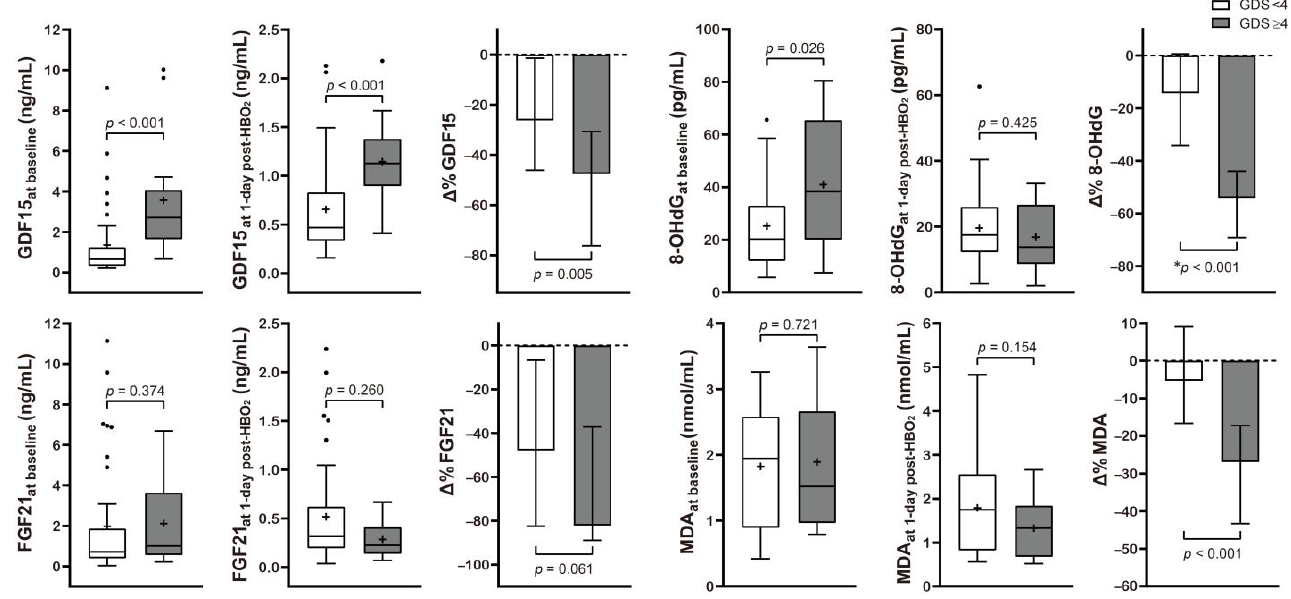
Figure 2. Serum level concentration of various mitochondrial and oxidative stress biomarkers in CO poisoning patients presenting with different neurocognitive outcomes. Data are presented as box and whisker Tukey plots with medians and interquartile ranges (+, mean; •, outliers). Comparisons of the biomarker levels between the favorable (GDS <4) and poor (GDS ≥4) neurocognitive outcome groups were completed using a two-sided Mann–Whitney U test or * independent t -test, as appropriate. The change (Δ%) in each parameter was calculated as follows: (1 day post HBO 2 therapy value − baseline value) / baseline value test) × 100.